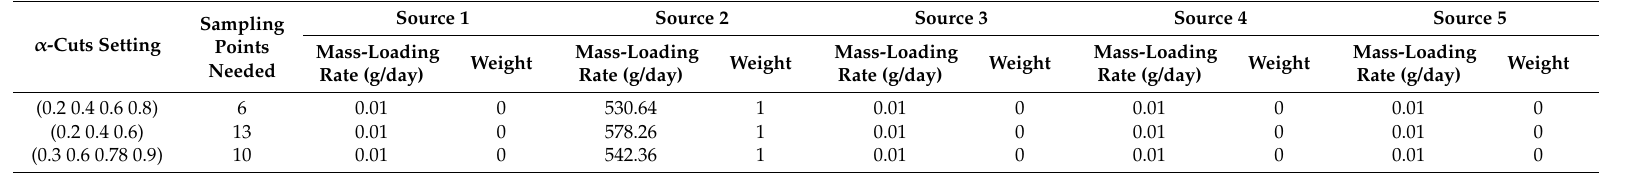
Table 3. Sensitivity analysis results of the α -cuts setting for pollution source identification.